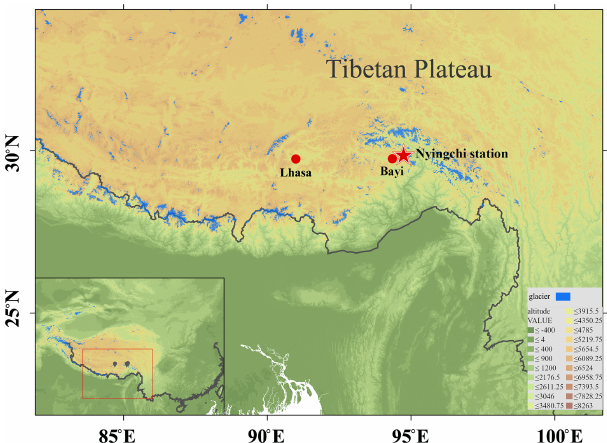
Figure 1. Location of the southern Tibetan Plateau station for in- tegrated observation and research of the alpine environment (SET station or Nyingchi station, the red star). SET station is located in a water vapor channel from the Ganges River Plain to the Ti- betan Plateau. The red dot is Lhasa, the capital city of the Tibet Autonomous Region, which is the most densely populated city in Tibet; the other red dot is the nearest town to the monitoring site, Bayi